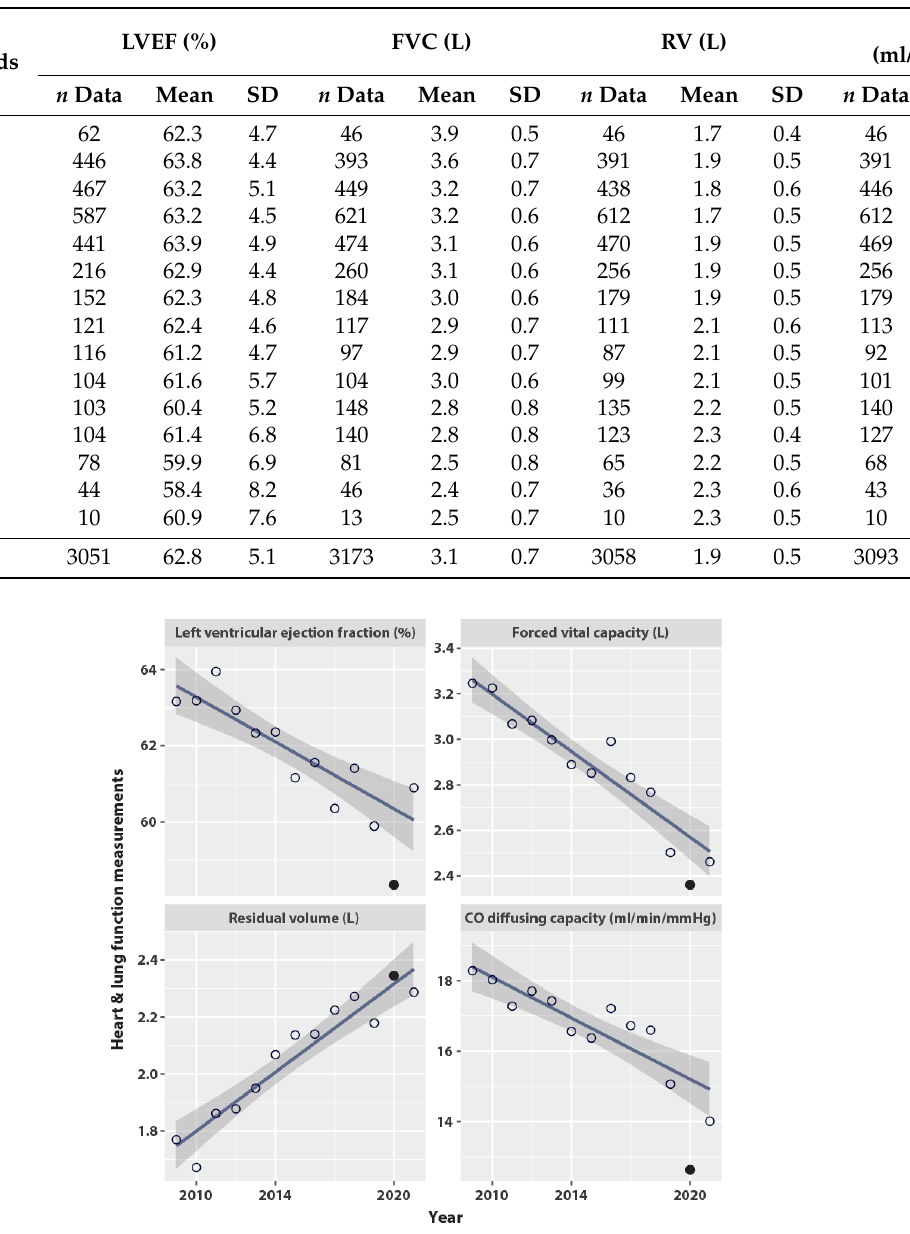
Table 4. Heart and Lung function. * Half-year data. SD, standard deviation. LVEF, left ventric- ular ejection fraction; FVC, forced vital capacity; RV, residual volume; DLCO, carbon-monoxide diffusing capacity.